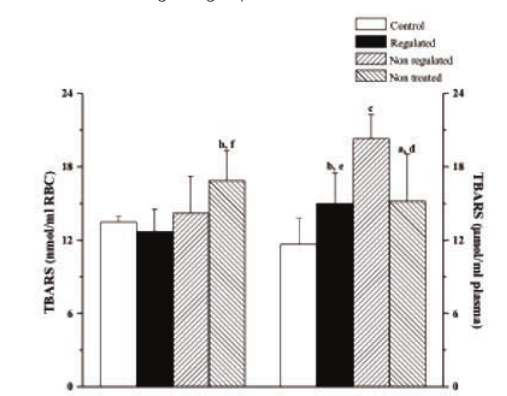
Figure 2. TBARS concentration in plasma and red blood cells of investigated